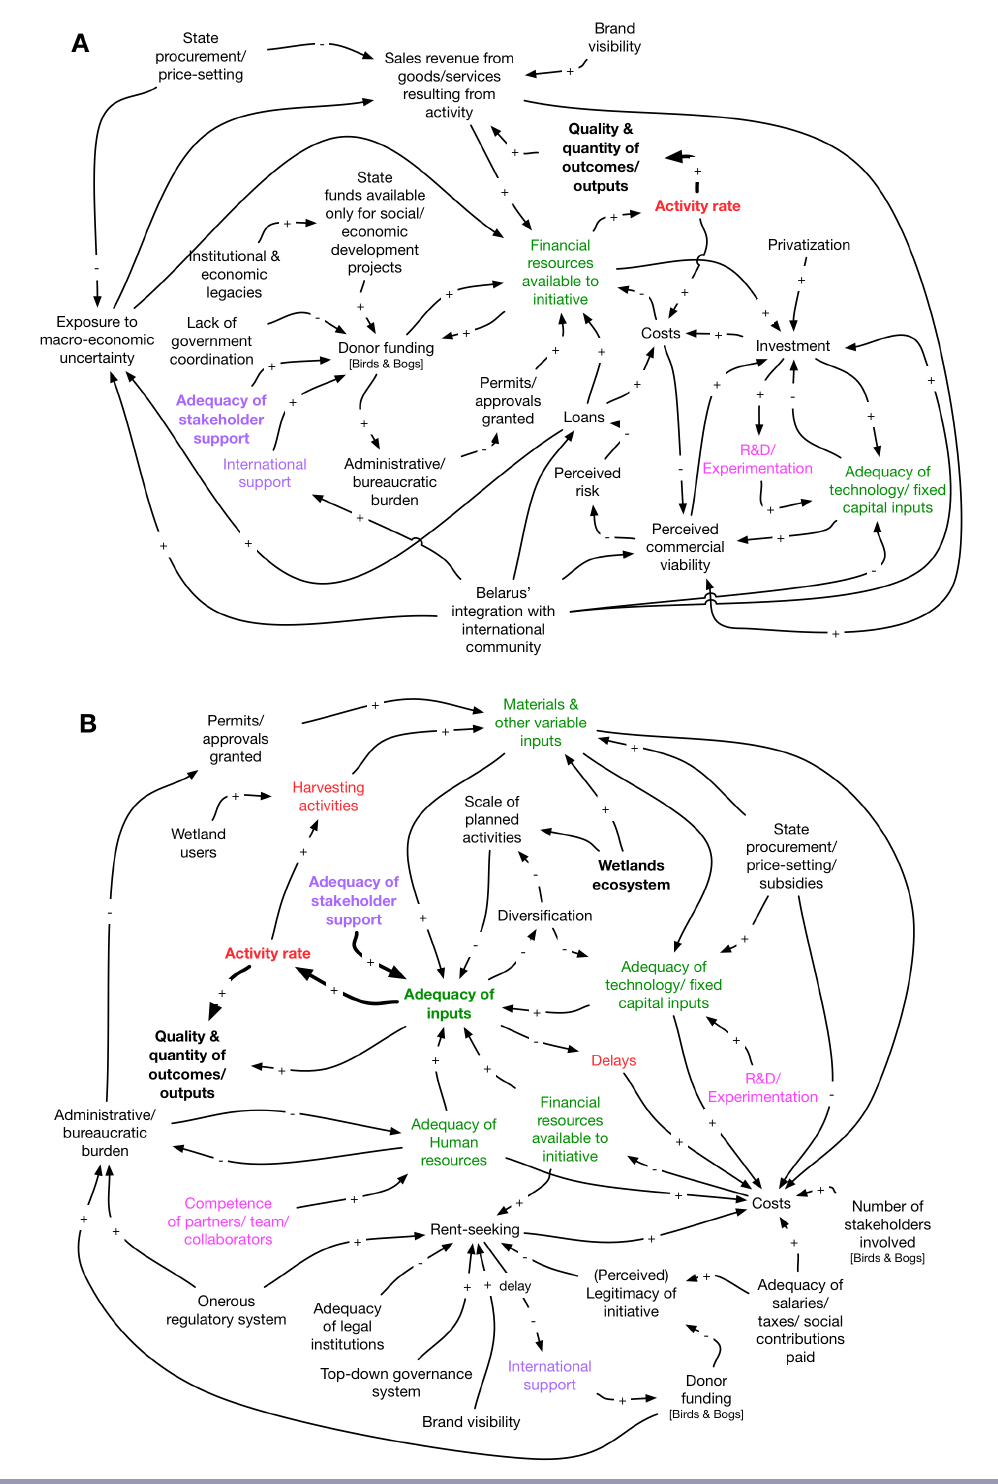
Fig. 7 . Submodels unpacking causal dynamics influencing adequacy of inputs for wetland restoration initiatives. Inputs are disaggregated into four main types: Financial resources, Technology/fixed capital, Human resources, and Materials and other variable inputs. Fig 7 is separated into two submodels simply to reduce diagrammatic complexity and aid reader comprehension. Links from support to the various disaggregated types of inputs are aggregated into one main link in